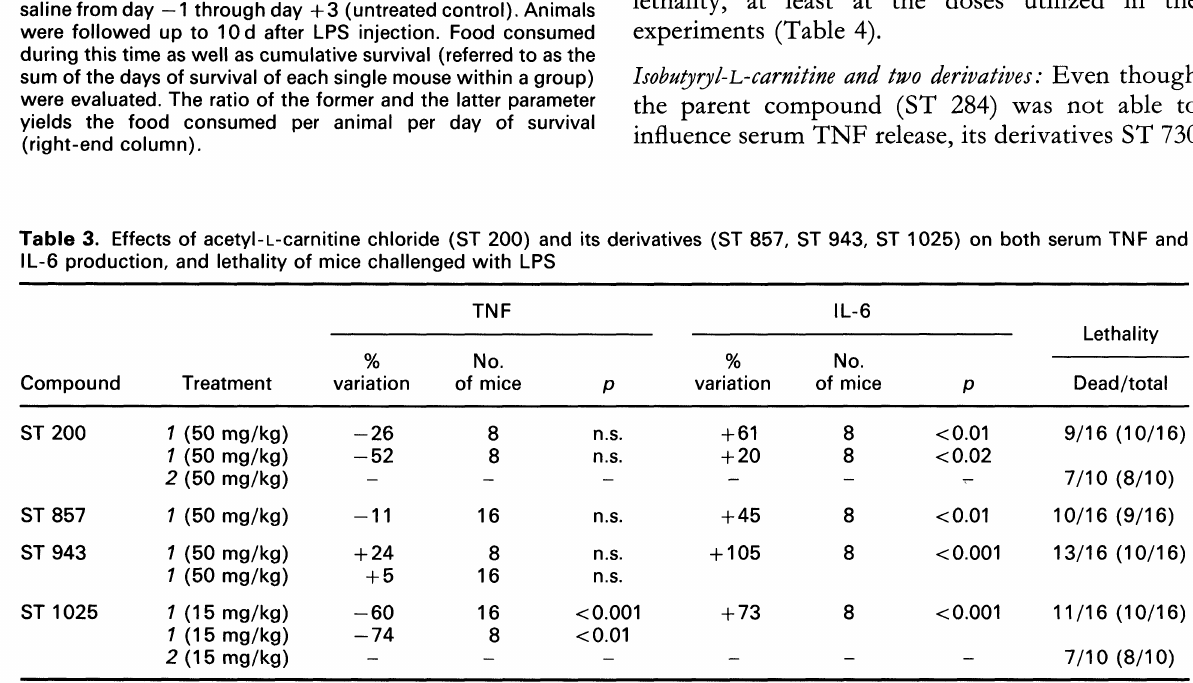
Treatments were performed by injecting LPS 30 mg/kg i.p. at time zero and administering the compounds, at the dose indicated, as follows: 1) -60 min i.p. and + 10 min i.v., 2) from